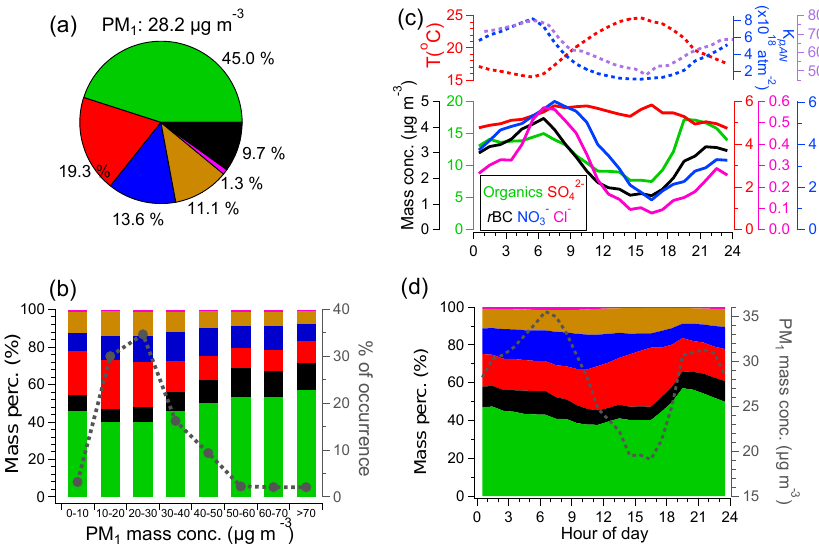
Figure 2. (a) Campaign-averaged mass contributions of organics, sulfate, nitrate, ammonium, chloride, and r BC to the total PM 1 ; (b) mass percentages of the six PM 1 species (left y axis) and fractions of the number of data points to the total number of data points for PM 1 at different concentration bins (right y axis); (c) diurnal patterns of mass concentrations of the major PM 1 species (bottom panel), temperature (top panel, left y axis), relative humidity (RH) (top panel, right y axis), and the equilibrium constant ( K p , AN ) of NH 4 NO 3 (top panel, right n (cid:16) 298 (cid:17) h (cid:16) 298 (cid:17) io − 1 + b − 298 y axis) ( K p , AN = K p , AN ( 298 ) exp a 1 + ln ; for reaction NH 4 NO 3 (p) ↔ NH 3 (g) + HNO 3 (g). K p , AN (298) T T T is the equilibrium constant at 298K (3 . 36 × 10 16 atm − 2 ), a = 75 . 11, and b = − 13 . 5; Seinfeld and Pandis, 2006); (d) diurnal variations of mass fractional contributions of the six PM 1 species (left y axis), and the PM 1 mass concentrations (right y